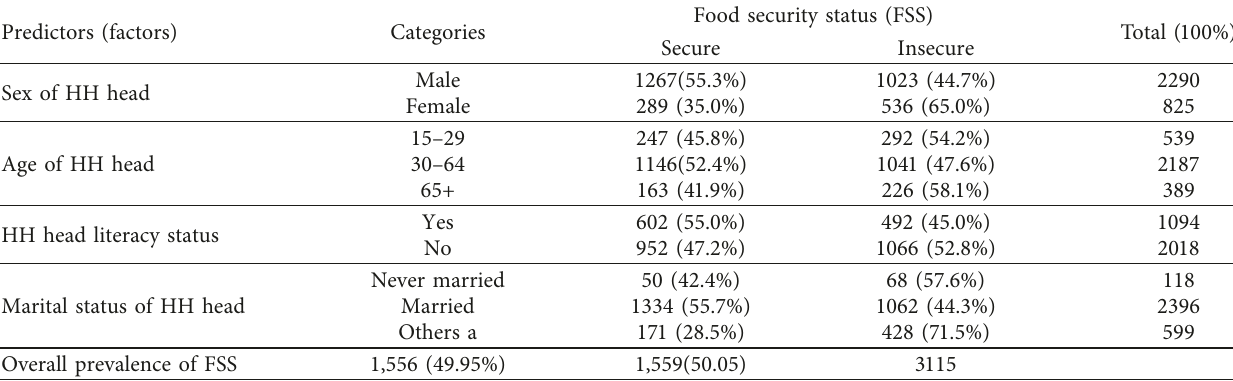
Table 1: Association of households’ food security status with some household head’s demographic characteristics in rural Ethiopia.